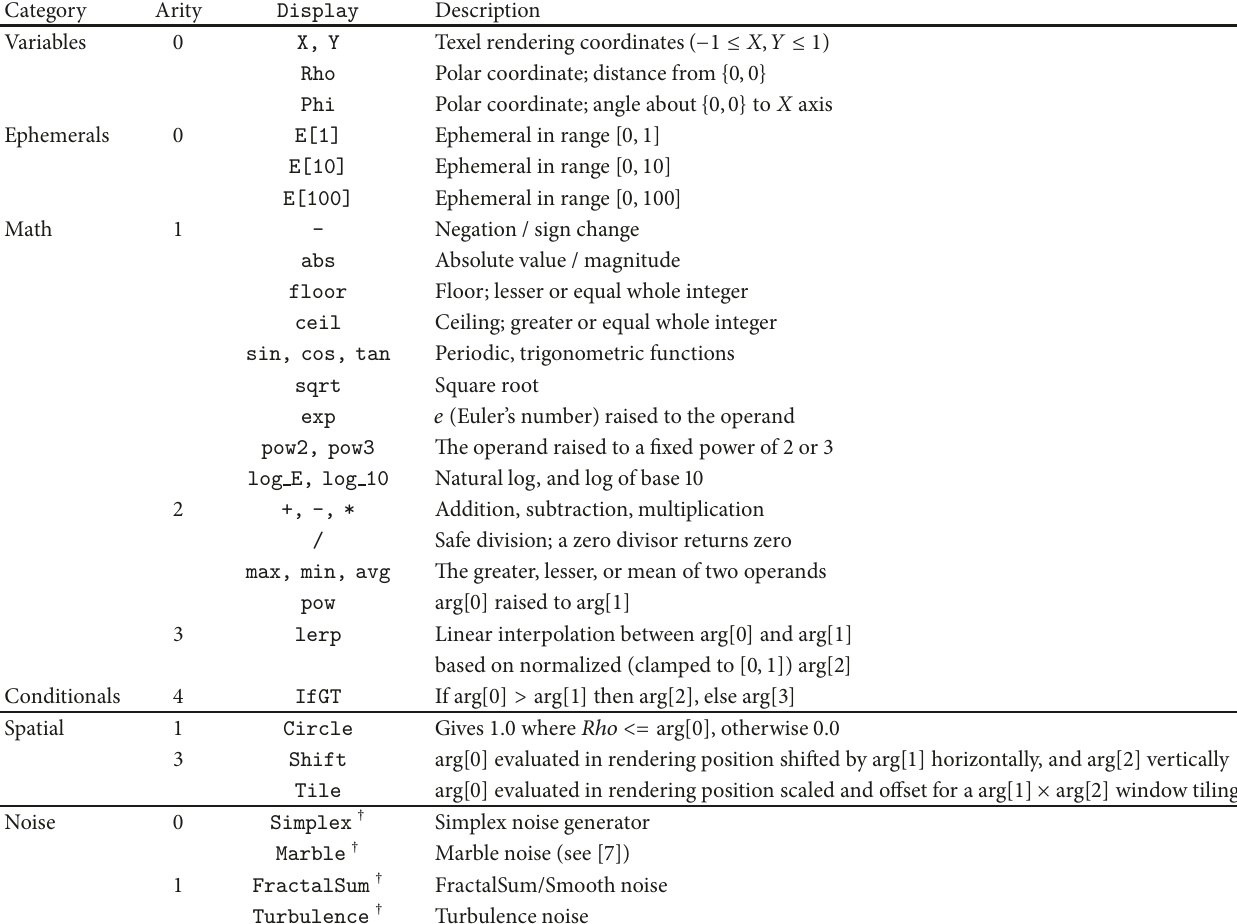
Table 2: Genetic programming engine base language overview.